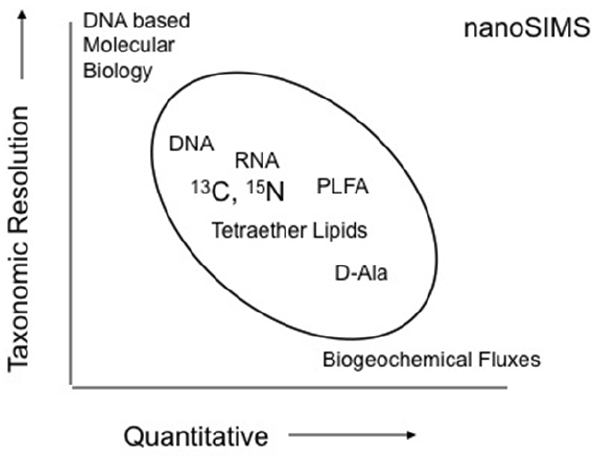
Fig. 2. Conceptual picture of the trade-offs between identity of organism and accurate biogeochemical flux measurement using (microbial) biomarkers. Biogeochemical rates measurement (often based on isotope tracer techniques) provide accurate quantification but no information on the identity of the organisms involved. Molec- ular biology tools provide high-quality information on the presence and potential capabilities of organisms but limited information on in situ rates. Compound-specific isotope characterization of biomark- ers (DNA, RNA, PLFA, Tetraether lipids, D-alanine) in combina- tion with tracer techniques provide rate as well as identity informa- tion but with low-to-moderate taxonomic resolution and intermedi- ate accuracy. NanoSIMS can provide individual cell isotope ratio measurements and thus provides high accuracy and high taxonomic resolution, as well as spatial